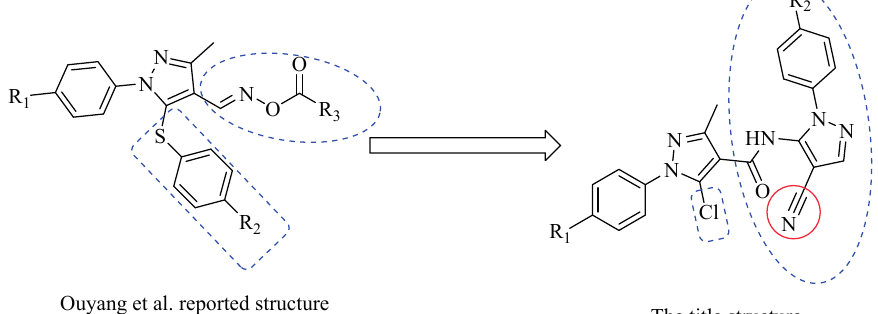
Figure 2. Design of the target compounds.